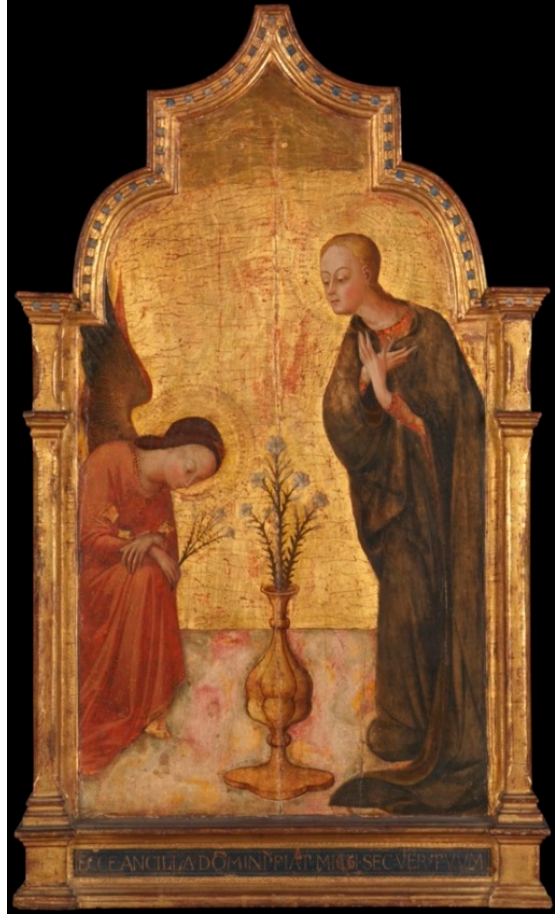
Figure 4. Sassetta, The Annunciation , c. 1437–1444. Metropolitan Museum of Art, New York.